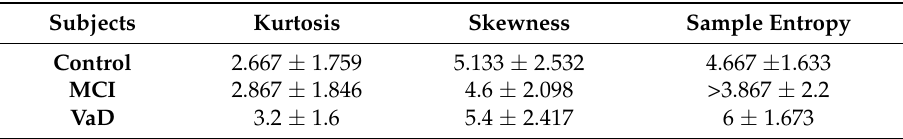
Table 3. Summary of the artifactual ICs detected by using Kurt Skw and SampEn for the VaD, stroke-related MCI patients and control subjects, (mean ± standard deviation